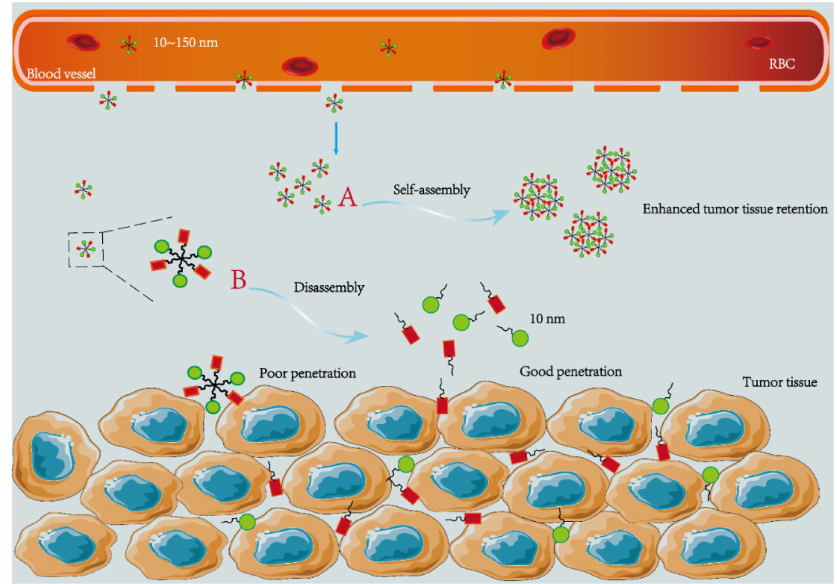
Figure 1. Schematic diagram of 10~150 nm particles transport in the body. The NPs consist of linkers that carry different small molecule drugs. ( A ) Self-assembly into large particles to enhance tissue retention; ( B ) rapid decomposition into small particles to improve tumor